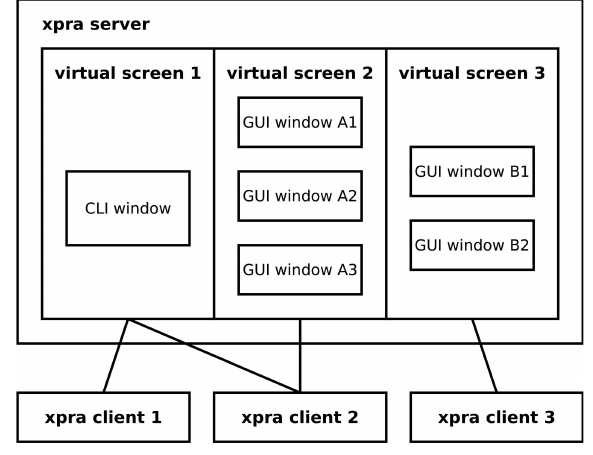
Figure 6 xpra provides virtual screens, each of which can be accessed by multiple clients